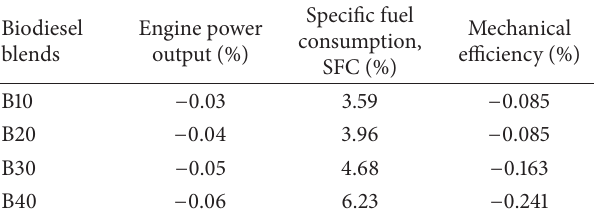
Table 3: The percentage difference for different biodiesel blends relative to conventional diesel, B0. Biodiesel